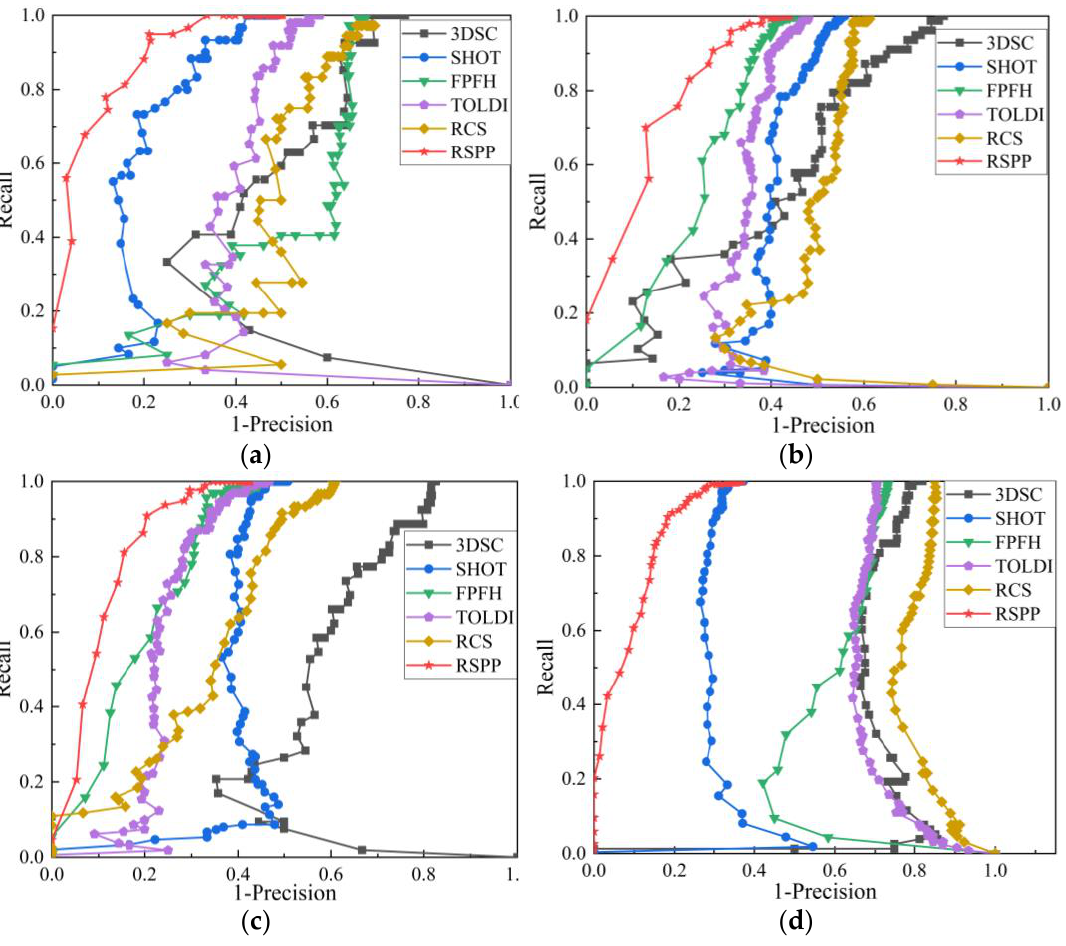
Figure 9. RP curves of different feature descriptors under 0.25 mr Gaussian noise: ( a ) RP curve of Bunny dataset; ( b ) RP curve of Buddha dataset; ( c ) RP curve of Dragon dataset; ( d ) RP curve of Armadillo dataset.